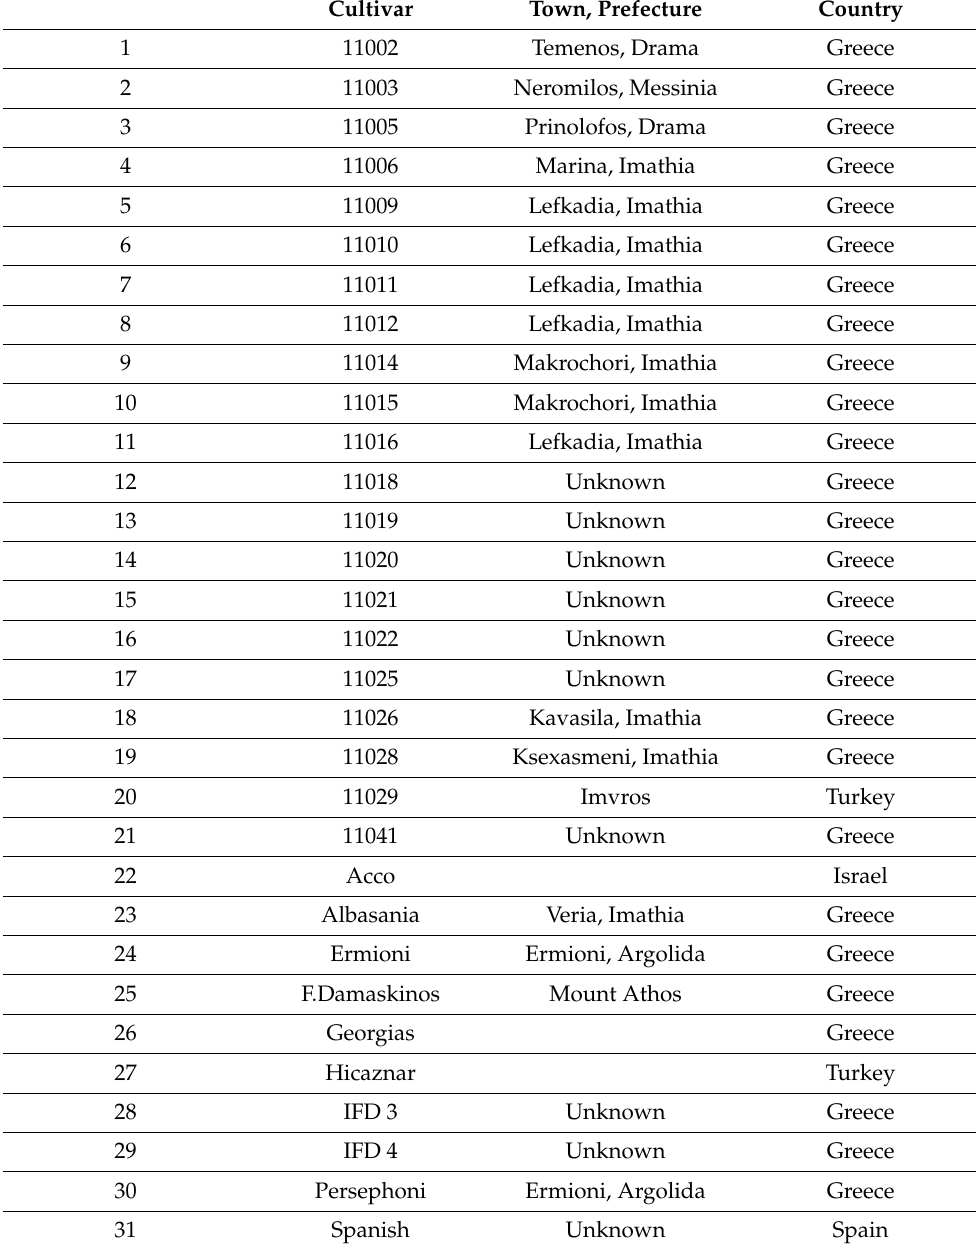
Table 1. Origin of the pomegranate accession/genotypes maintained in the ex situ collection at the Department of Deciduous Fruit Trees in